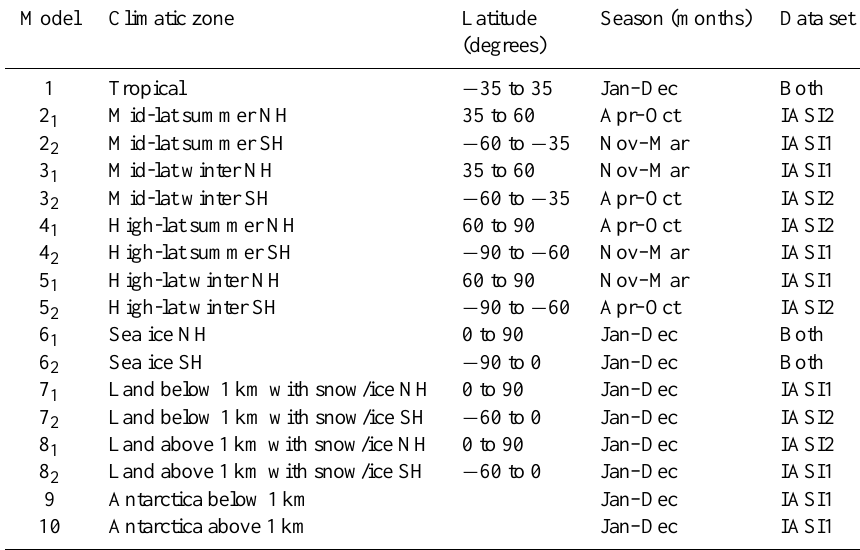
Table 1. Definition of climate zones as a function of latitude and